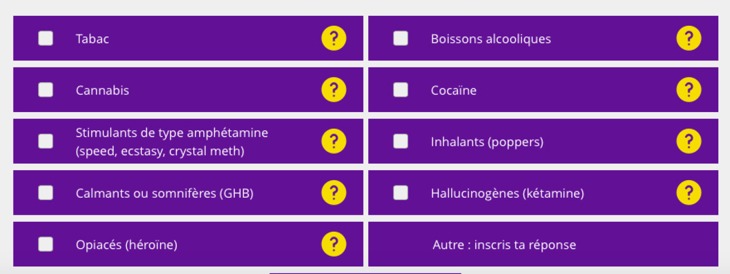
Example of some ASSIT (53) questions.